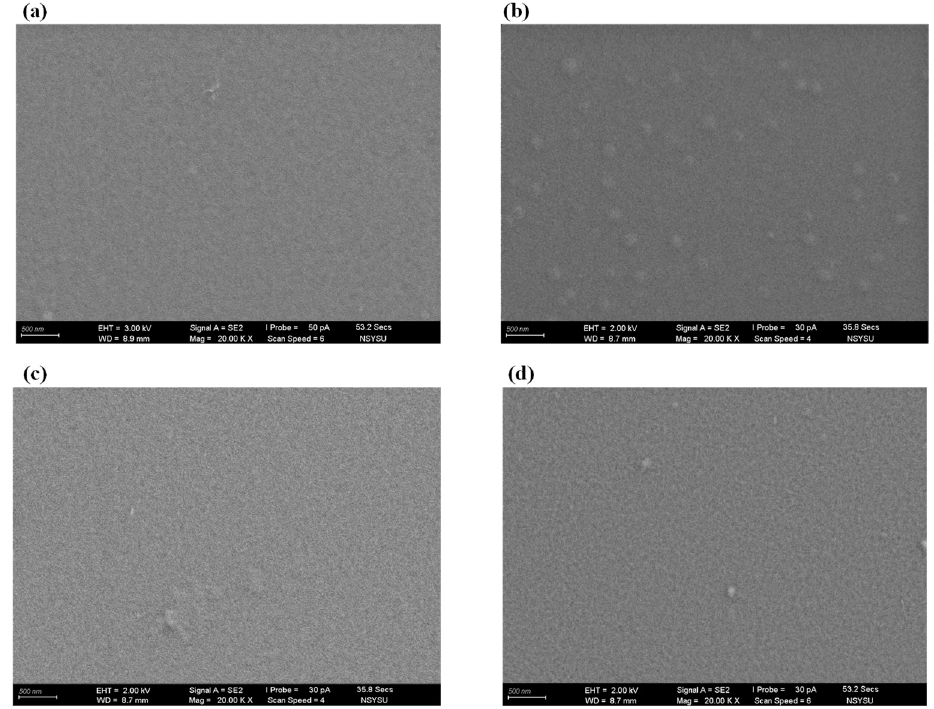
Figure 5. SEM images of ( a ) PEDOT: PSS, ( b ) PEDOT: PSS-sorbitol (4 wt%), ( c ) PEDOT: PSS-maltitol (4 wt%), ( d ) PEDOT: PSS-sorbitol-maltitol (3:1).